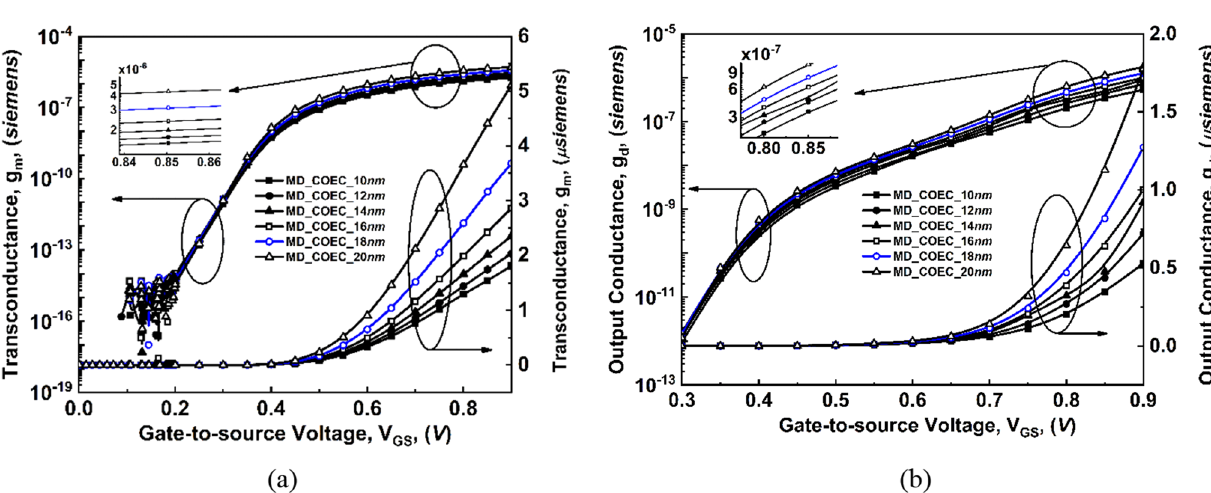
Figure 12. Comparison of variation of transconductance (g m ) and output conductance (g d ) as a function of gate voltage at V DS = 0.3 V for COEC devices: ( a ) g m , and ( b ) g d